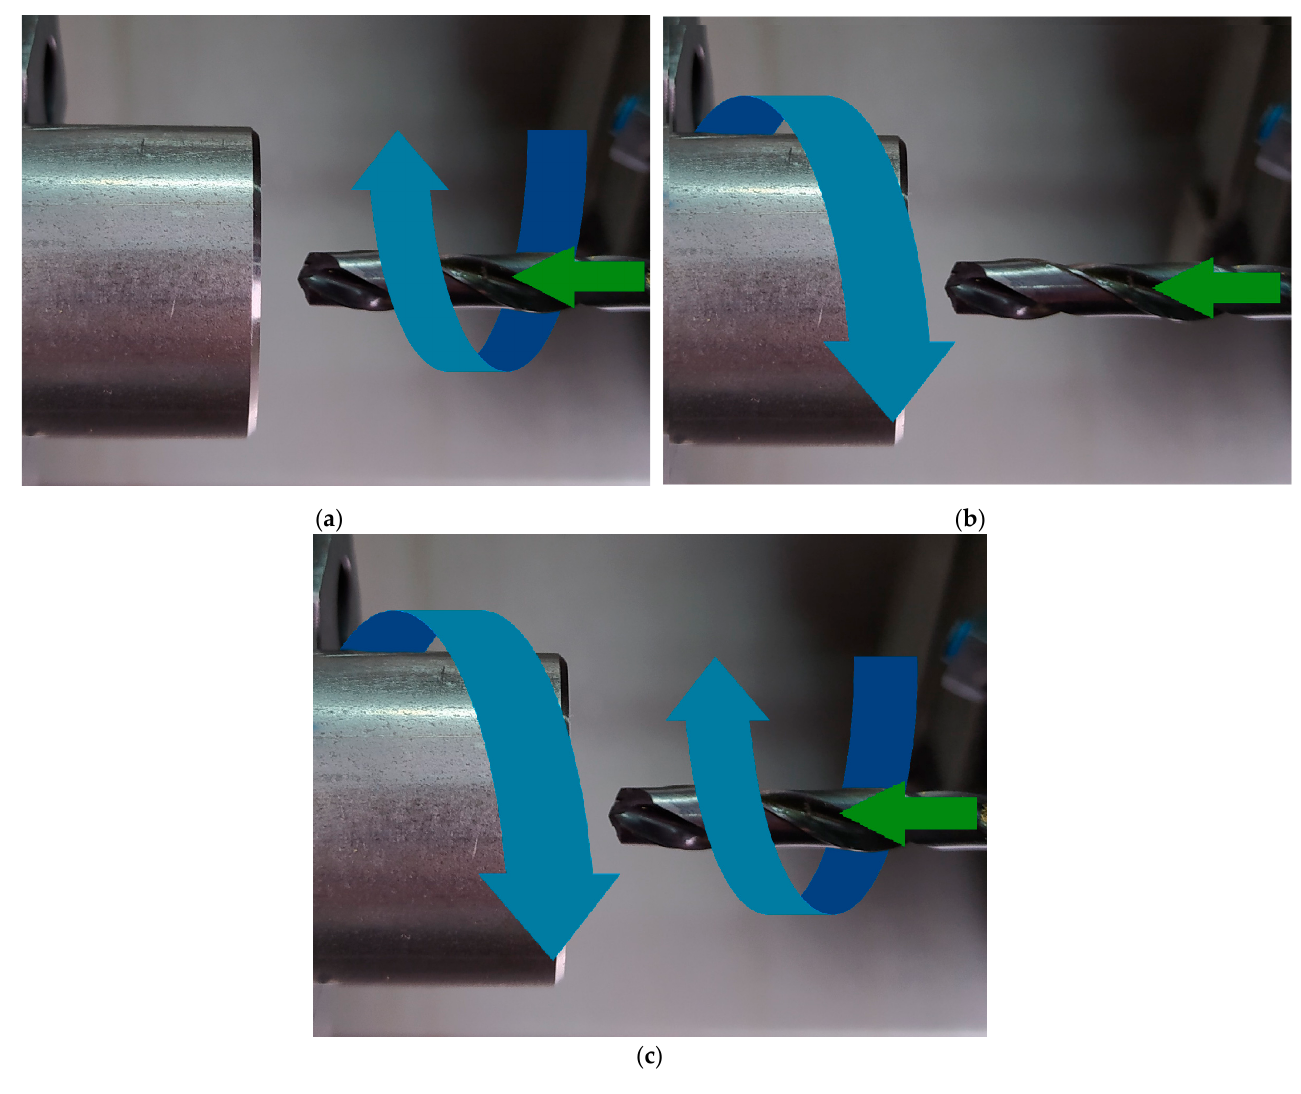
Figure 1. Drilling strategies: ( a ) Strategy I, ( b ) Strategy II, and ( c ) Strategy III. Equation (1), used to analyze the deep through hole drilling strategies, is based on the difference between the tool speed and the spindle speed.